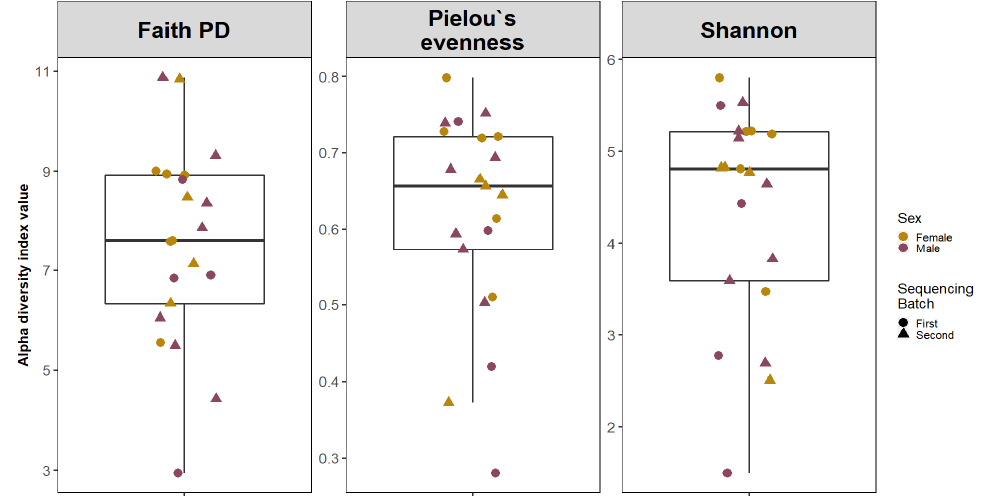
Figure 2. Beta diversity of adenoid microbiome samples. The plots show the composition of different adenoid microbiome sample subgroups: comparing female and male subjects and different interquartile ranges of Faith’s phylogenetic index (Faith PD), Shannon diversity index and Pielou’s sequencing batches. Each point represents the microbiome signature of one sample, where different evenness colors represent the various sample subgroups. The separation of samples is based on principal components, and the confidence level is set to 95% for ellipses. The overlap of ellipses in both figures indicates similar microbiome composition in the tested subgroups.